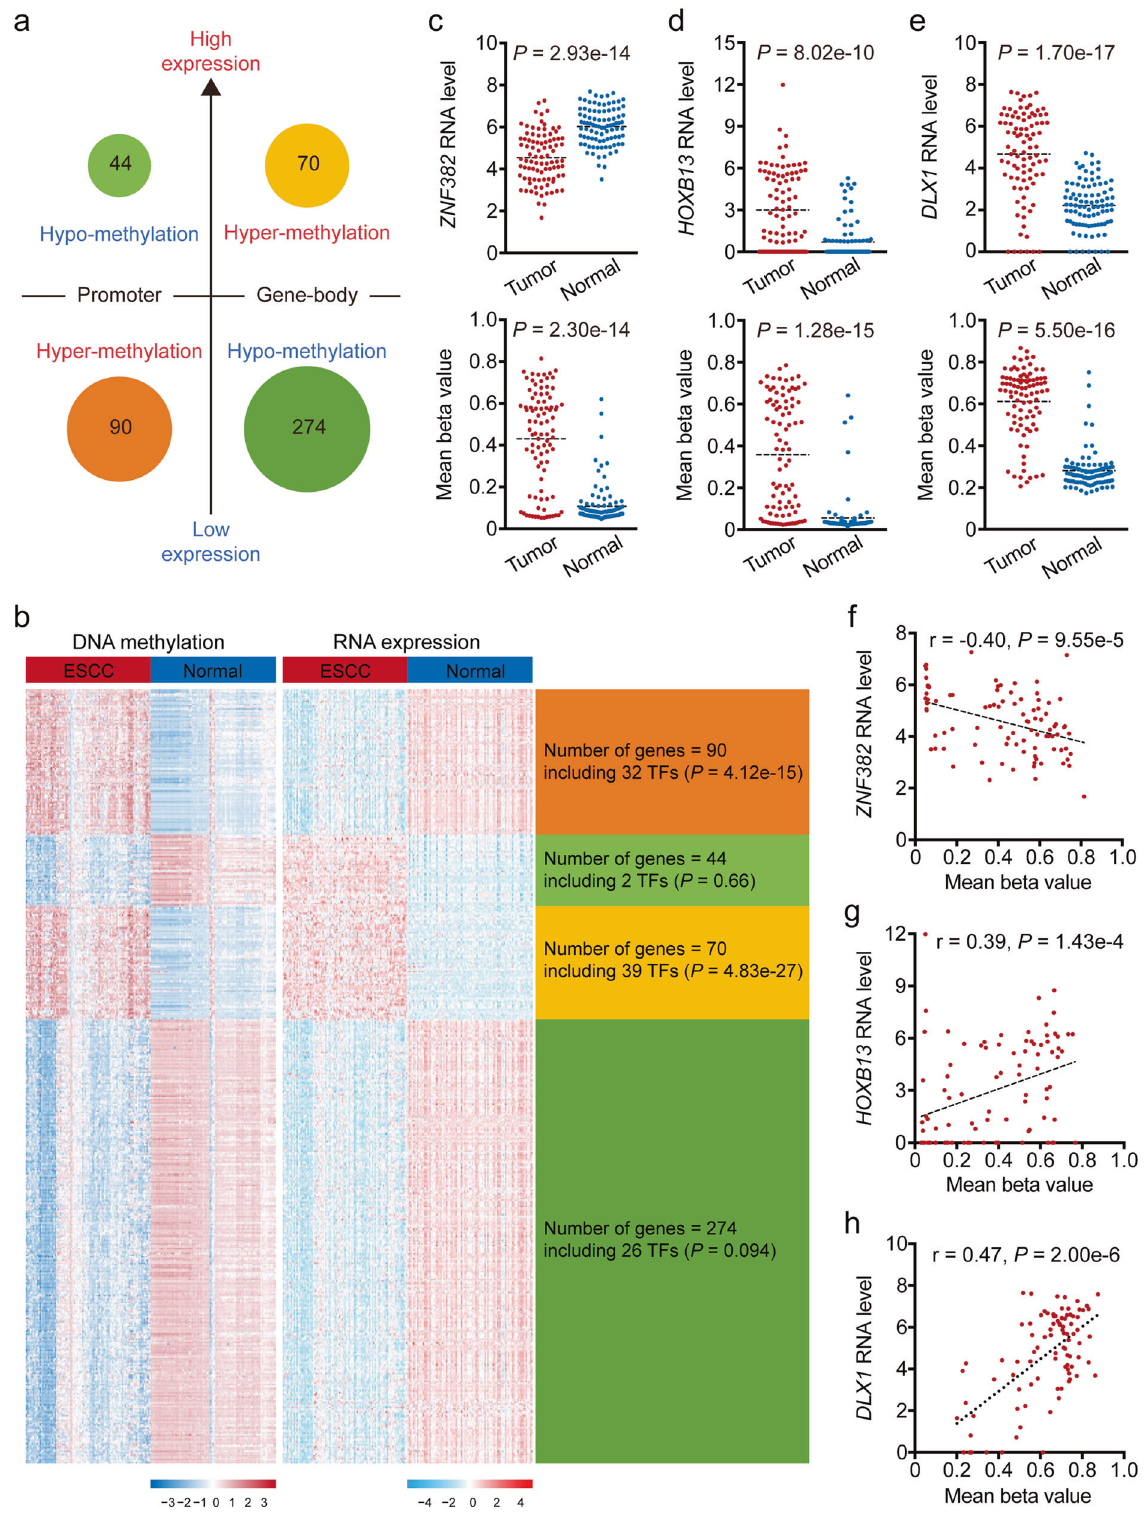
tissues and 2064 DMCs associated with 29,321 SNPs in adjacent normal tissues (Supplementary Data S4, 5 and Supplementary Fig. S4). Compared with adjacent normal, 1974 DMCs lost genetic control in tumor genomes and 202 DMCs gained new correlations. Moreover, ESCC-associated SNPs (14,761, nominal P <